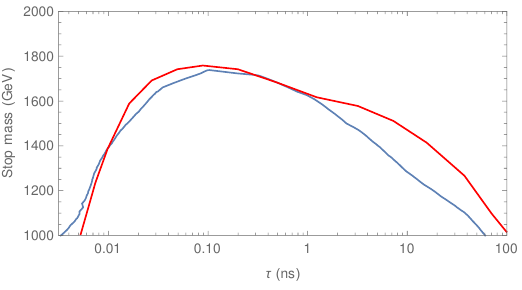
Figure 18. Validation of the DV + µ search by ATLAS. The red curve is the ATLAS result, the blue curve is our reinterpretation using the available efficiency